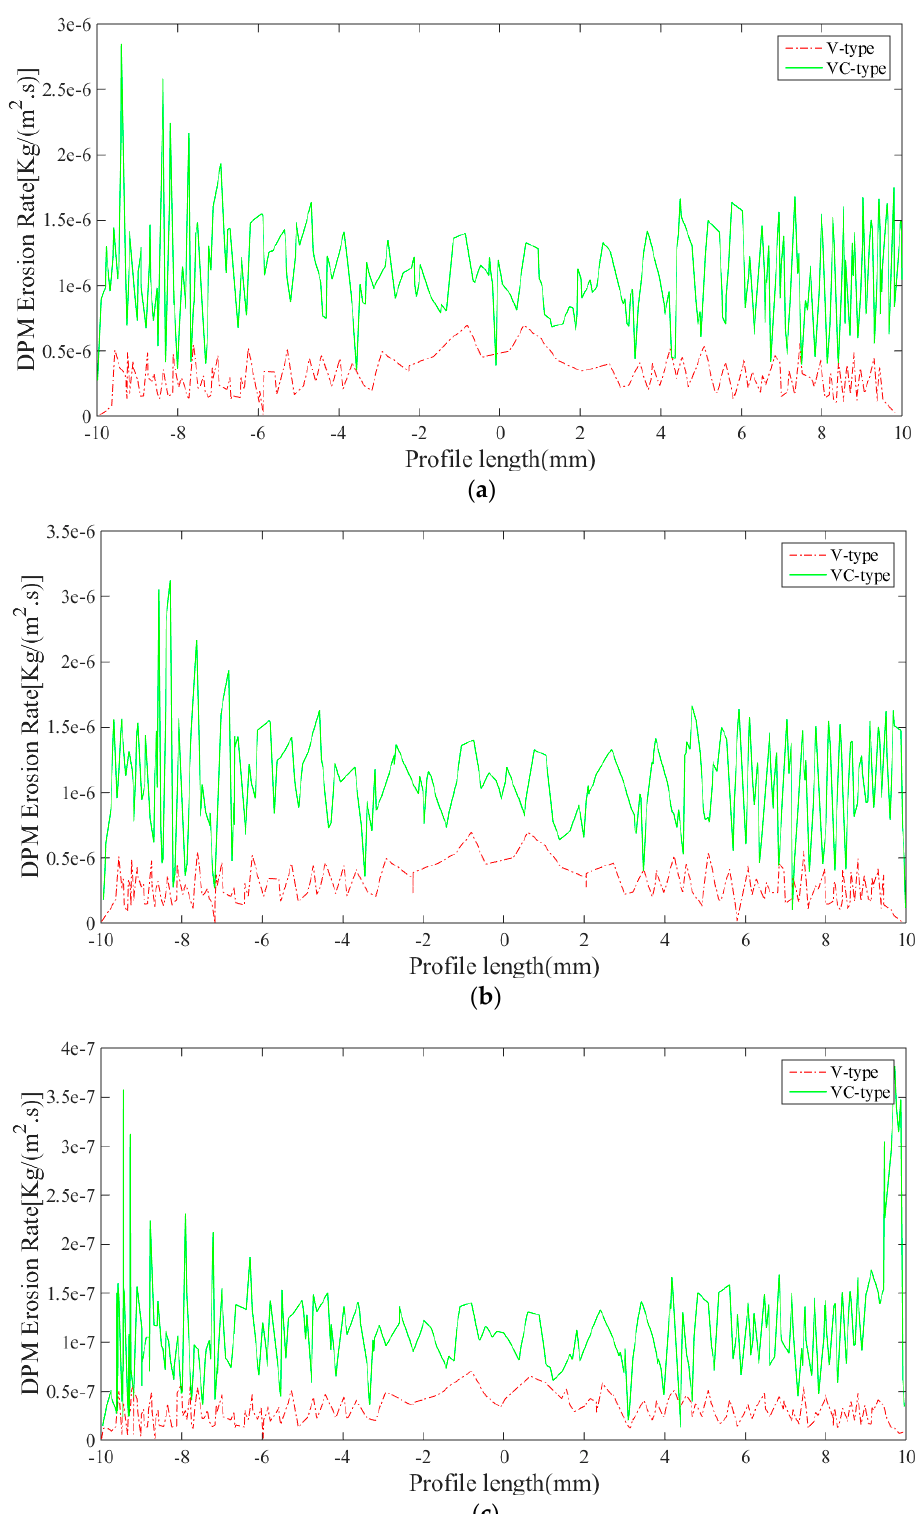
Figure 14. Erosion rate curves of bionic coatings at different speeds at 0° angle of attack: ( a ) V P = 70m/s; ( b ) V P = 150 m/s; ( c ) V P = 200 m/s. Table 8. Average erosion rates of the two types of bionic coatings at different impact speeds.